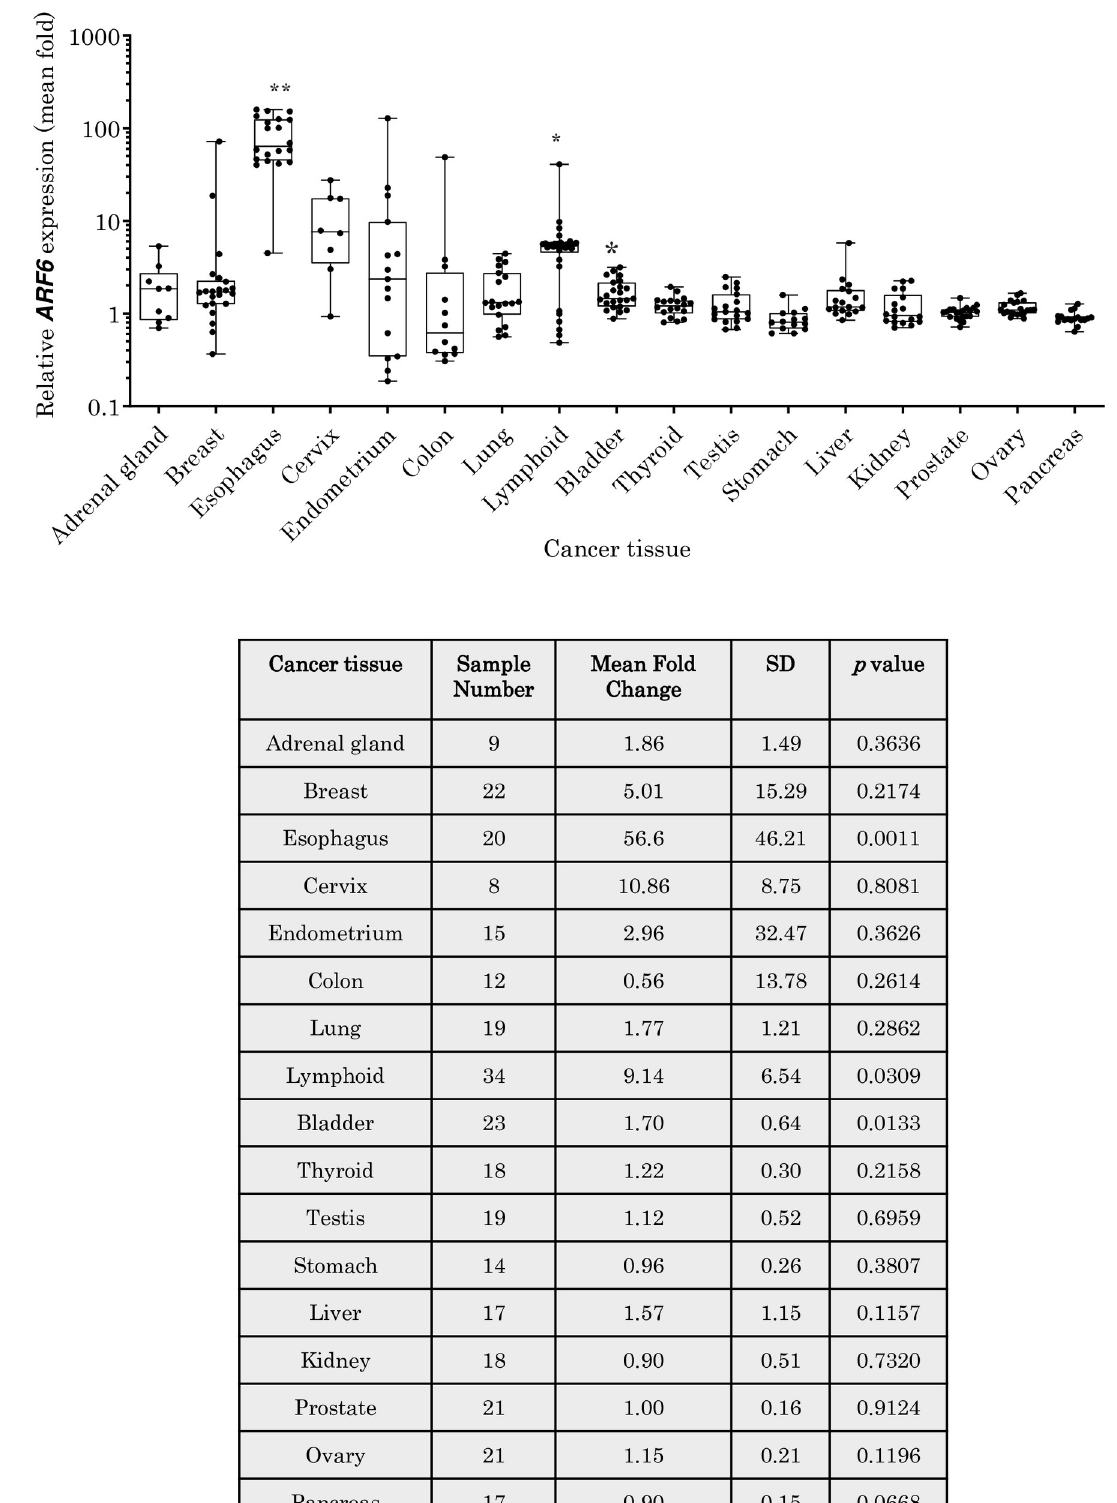
Fig 3. The expression of ARF6 mRNA in human cancer tissues. Relative folds change in expression of ARF6 mRNA in cancerous tissues when compared to that in healthy corresponding tissues. Data is shown using a box plot with whiskers showing + SD.